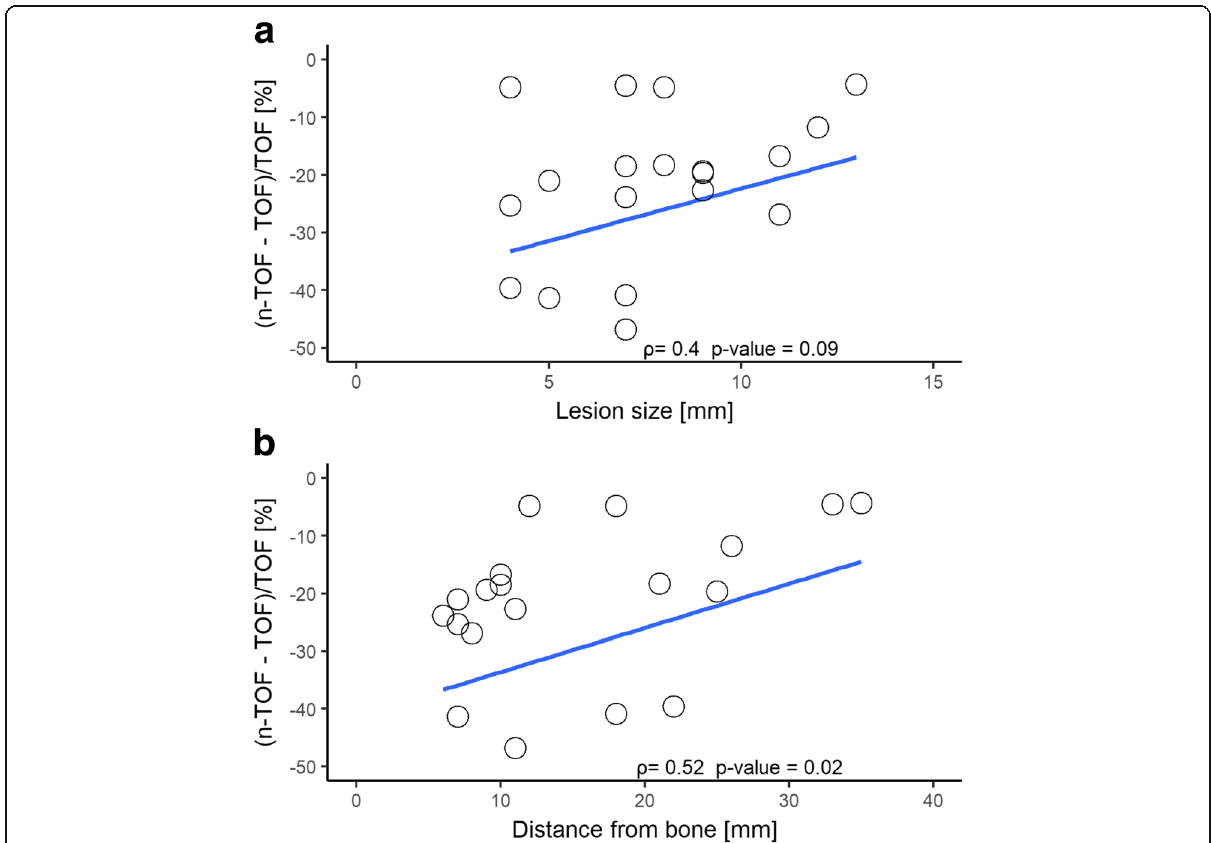
Fig. 3 Relative maximum standard uptake value (SUV) differences for lymph node metastases according to lesion size ( a ) and distance of the lesion from the bone ( b ). Note the increasing relative difference with decreasing distance from the bone and decreasing lesion size. The line represents the Spearman ’ s rank correlation and ρ the Spearman ’ s rank correlation